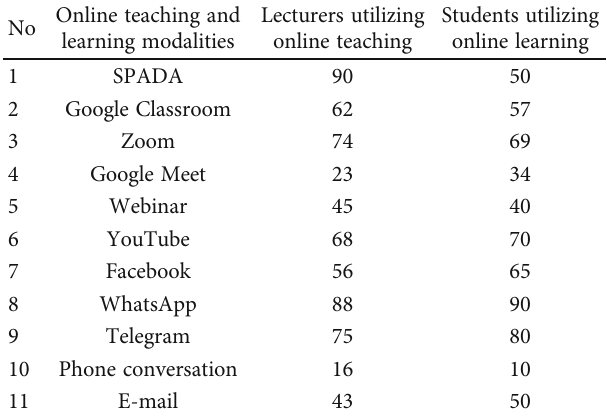
Table 3: Online teaching techniques adopted by lecturers and